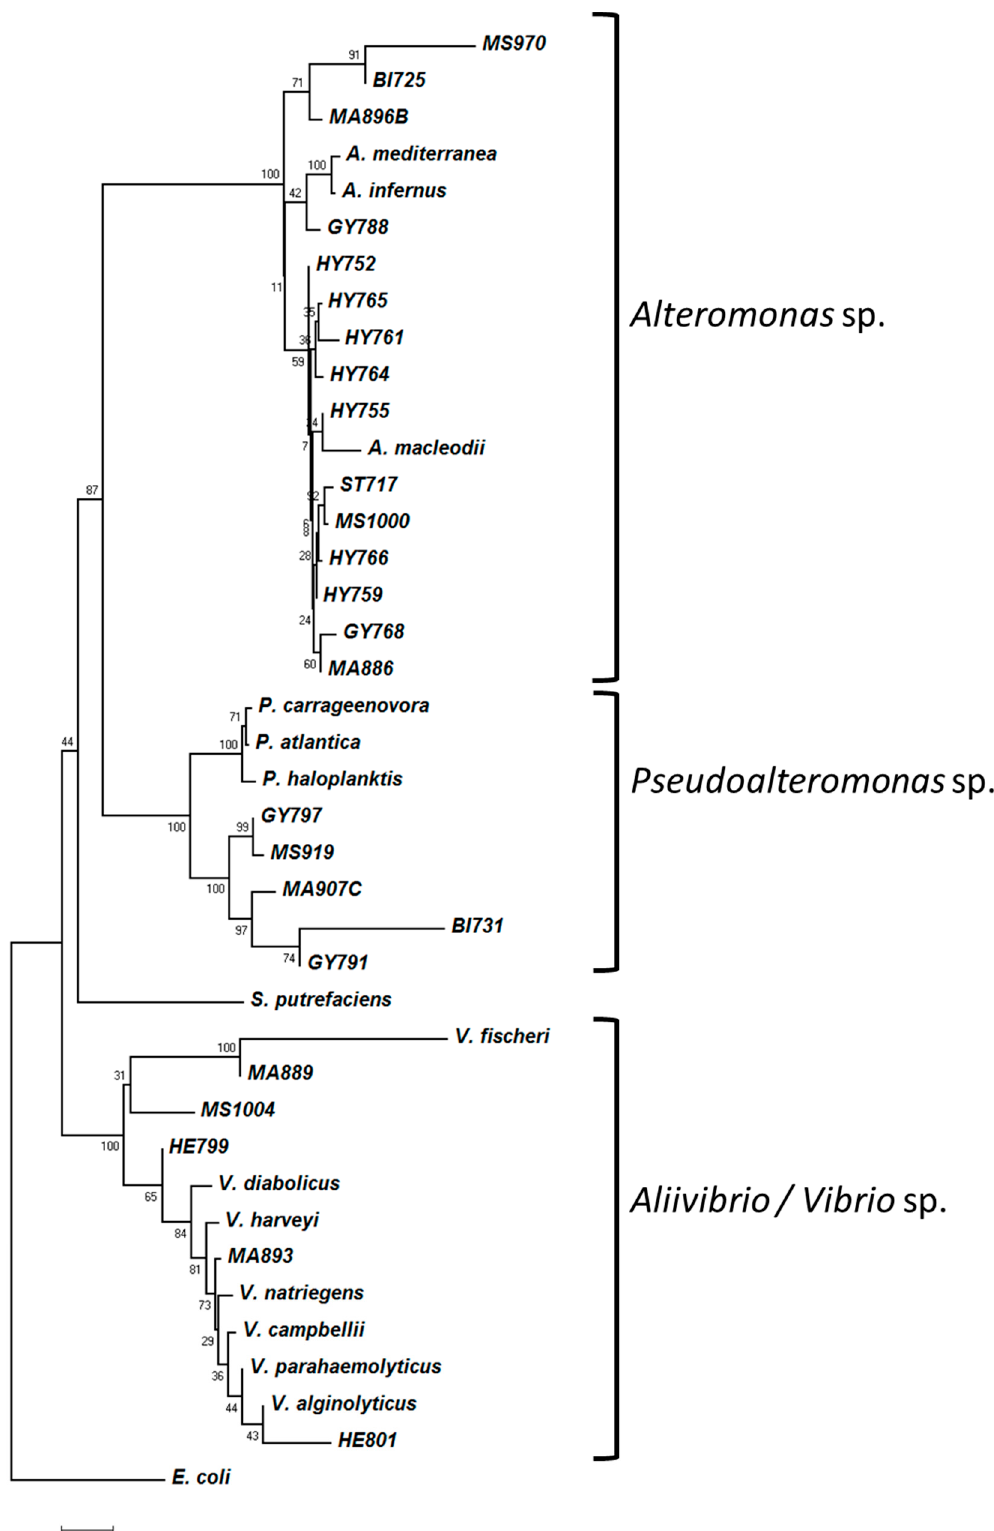
Figure 3. Phylogenetic relationship of the EPS-producing strains studied.